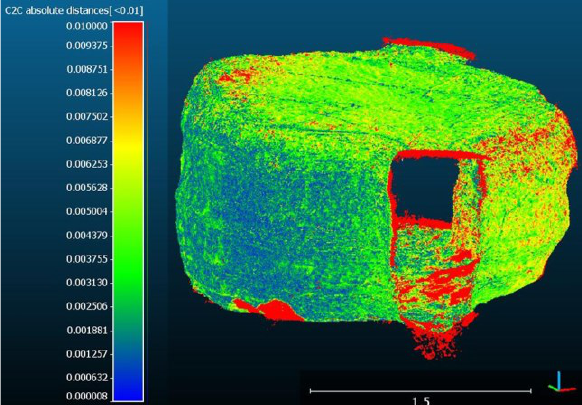
Figure 11 . Room 23: C2C analyses between the P30 and GoPro point clouds (calculation range: 0.00-0.01